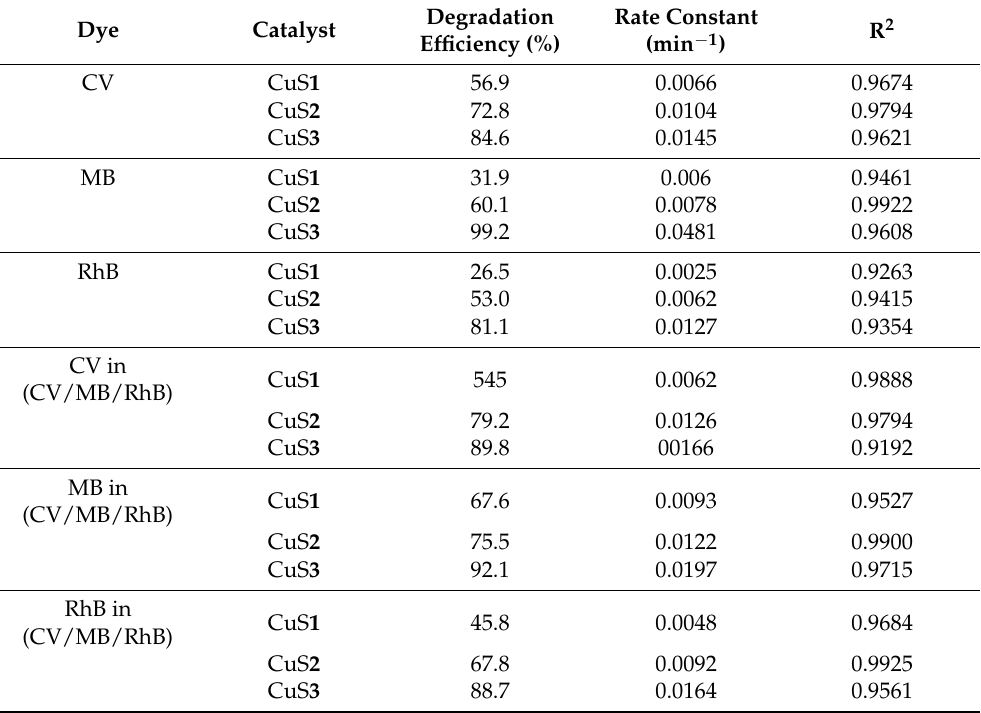
Table 2. The photocatalytic degradation parameters of single and mixed dye over CuS nanoparticles under visible light